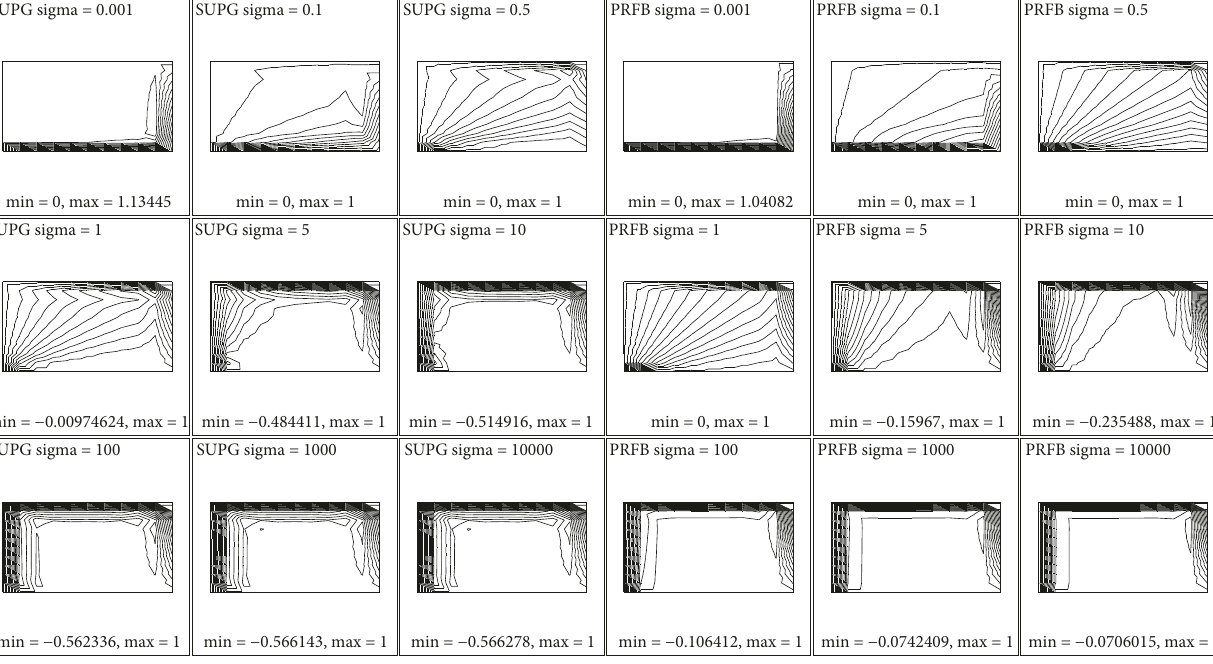
Figure 18: The corresponding contour